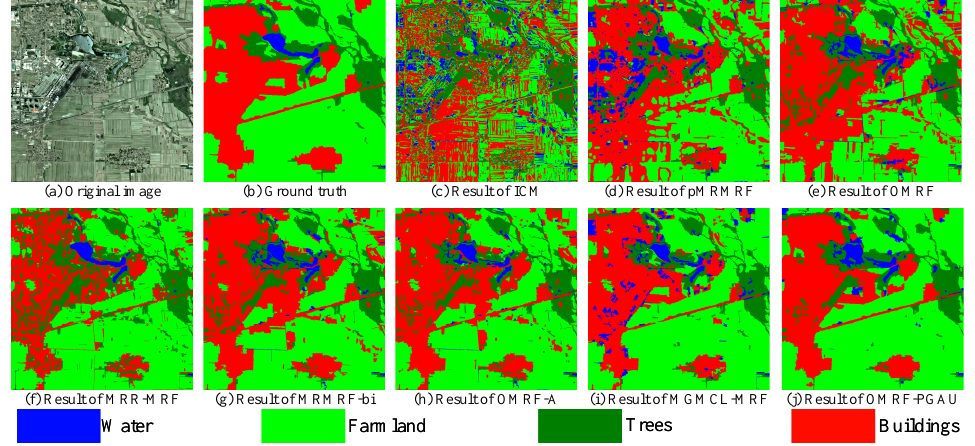
Figure 11. Semantic segmentation results for big size SPOT5